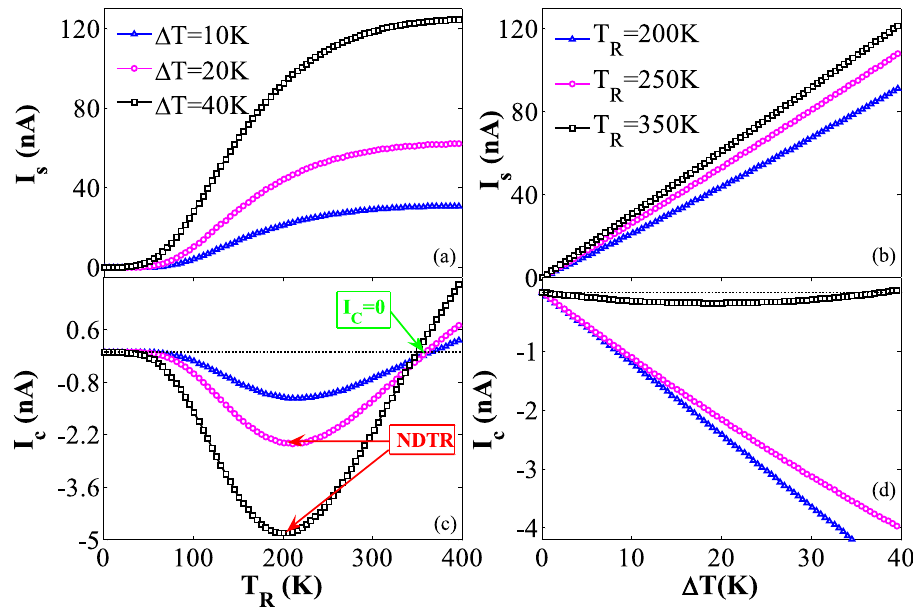
Figure 4. ( a ) The variation of the net spin current ( I S = I up − I dn ) versus T R for ∆ T = 10, 20, and 40 K, ( b ) the variation of I S versus ∆ T for T R = 200, 250, and 350 K, ( c ) the total electron current ( I C = I up + I dn ) as a function of T R for ∆ T = 10, 20, and 40 K, and ( d ) the variation of I C versus ∆ T for T R = 200, 250, and 350 K.